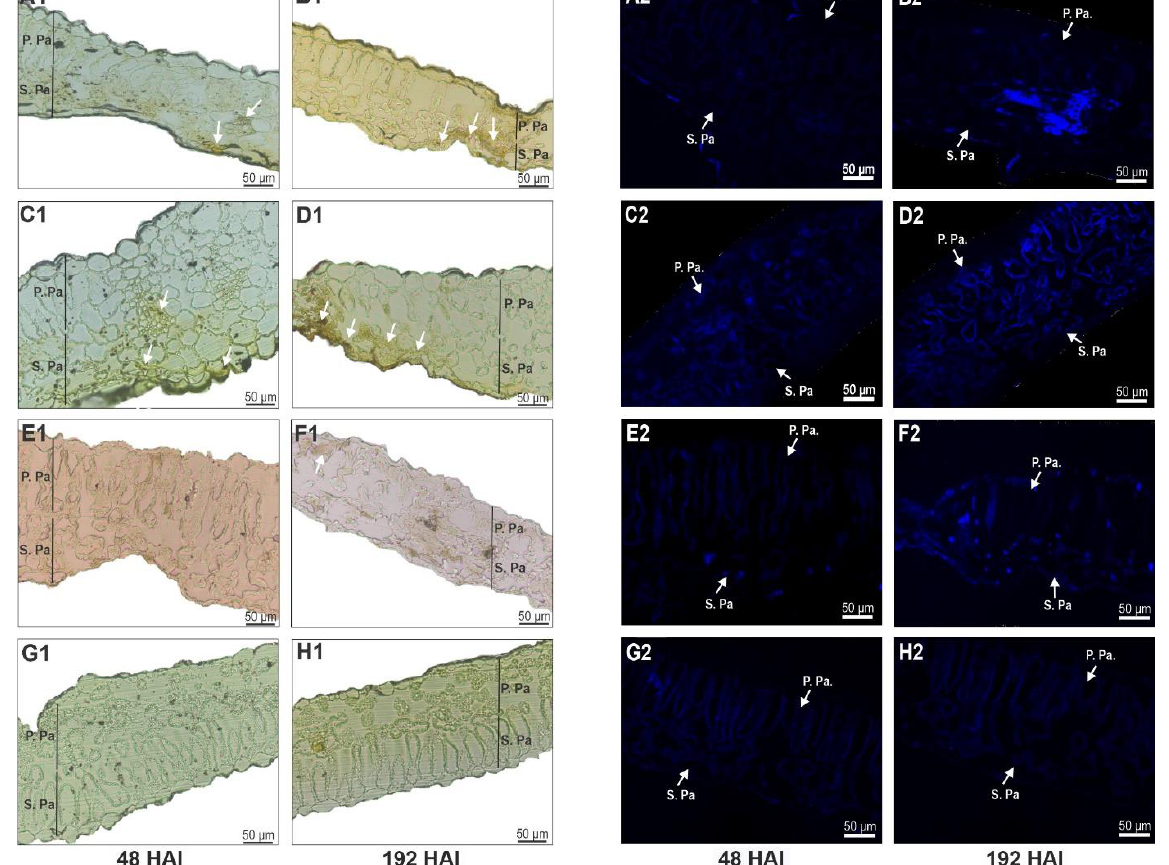
Figure 9. Photomicrographs ( A1 – H1 ) and epifluorescence images ( A2 – H2 ) showing phenolic compound accumulation and callose deposition, respectively, in leaf tissues of tomato plants infected by Alternaria linariae at 48 and 192 h after inoculation (HAI). Micrographs of transverse leaf sections (8 μm width) previously embedded in historesin. Treatments: thyme essential oil ( A , B ); Bacillus amyloliquefaciens MBI600 ( C , D ); inoculated plants ( E , F ); and uninoculated plants ( G , H ). Arrows (left panel) indicate accumulation of phenolic compounds (with a color between brown and dark yellow) after staining with ferric chloride. P. Pa. and S. Pa. indicate the palisade and spongy parenchyma tissues, respectively. Leaf tissue regions with high fluorescence (right panel) intensity indicate greater accumulation of callose after staining with aniline blue (0.005%) under observation with a Zeiss 49 blue filter (excitation = 365 nm; emission 445/50 (420 – 470 nm).